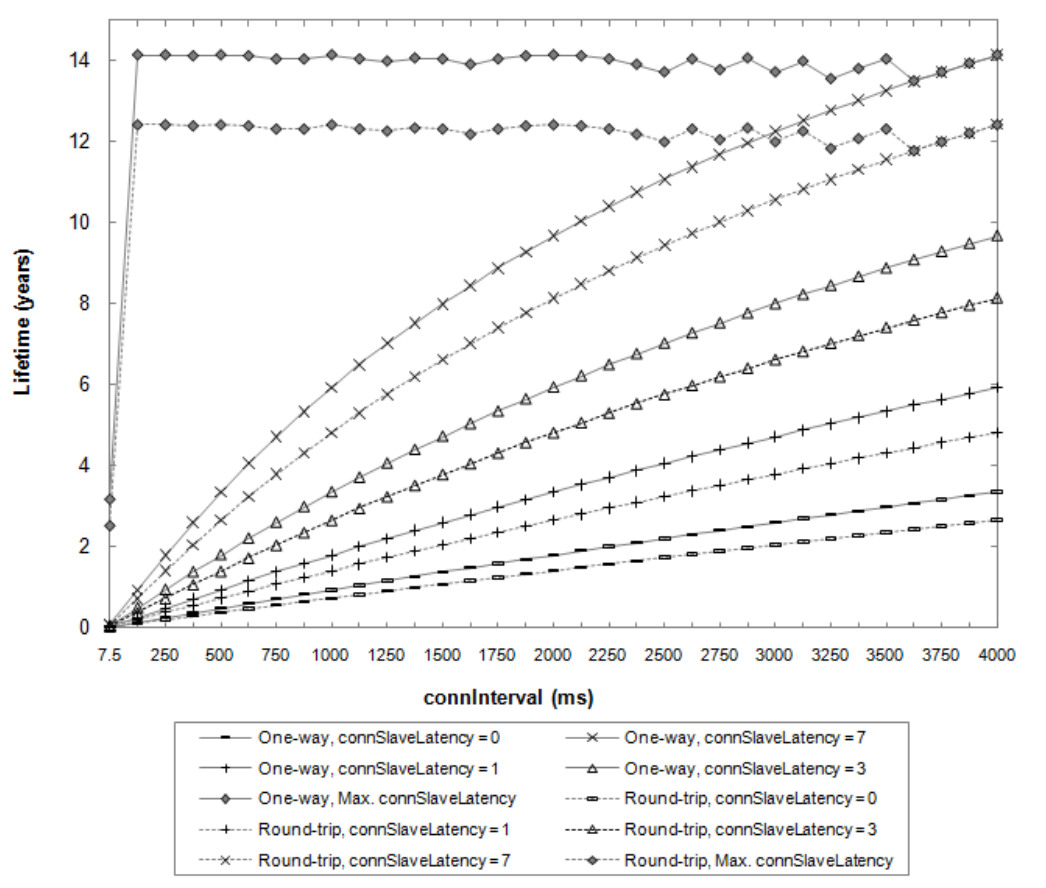
Figure 2. Theoretical lifetime of a slave for one-way and round-trip ATT message exchanges, and for different parameter configurations, based on CC2540 current measurements